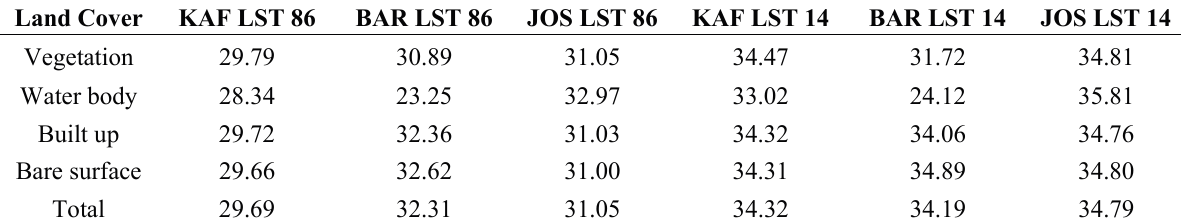
Table 13. Mean land surface temperature (LST) (°C) across landcover and regions. Land Cover